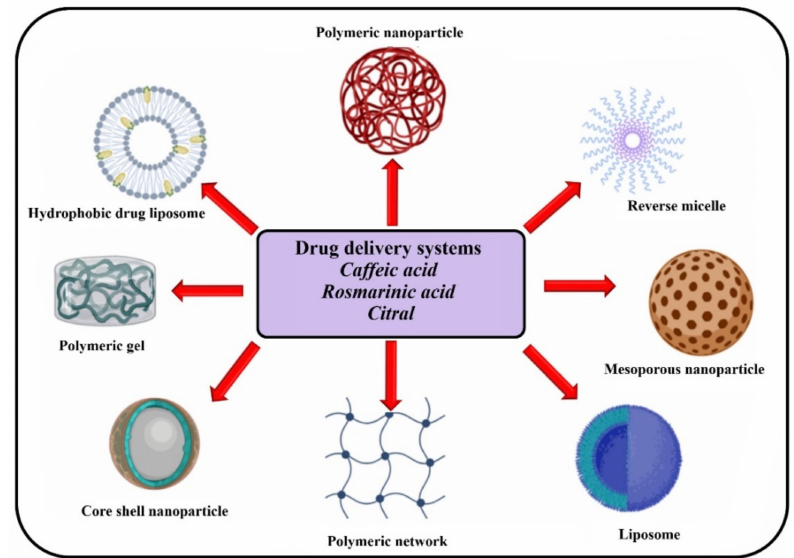
Figure 2. Drug delivery systems for Melissa officinalis components (realized with BioRender.com, accessed on 7 March 2022). Table 6. Controlled release systems with active substances which are available in Melissa officinalis